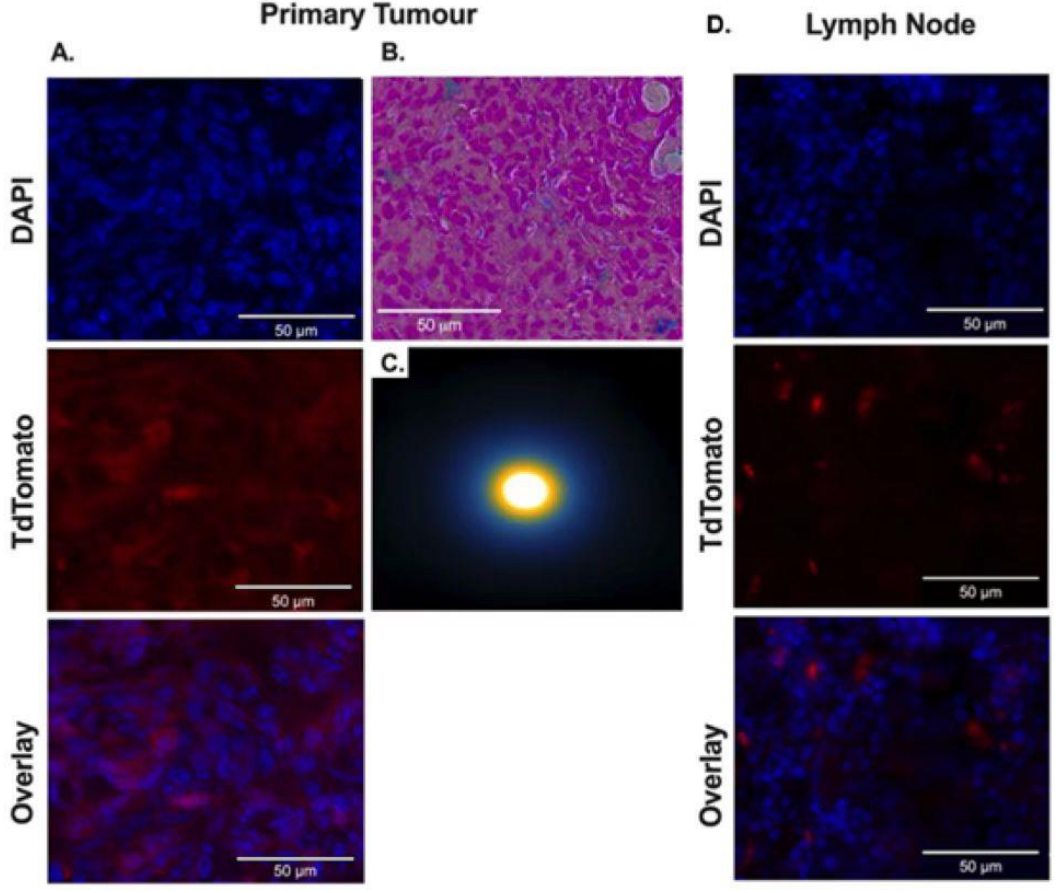
Figure 6. Ex vivo histology at endpoint. ( A ) Representative histology from the primary tumor and left axillary lymph node of mouse 3. DAPI (blue) stains all cell nuclei. Fluorescence in the tdTomato (red) channel confirms expression of the transduced reporter. All cells of the primary tumor (left column) were positive for tdTomato, and only a small fraction of cells in the lymph node were positive for tdTomato (right column). ( B ) PPB stain is displayed for one section of the primary tumor. Iron (blue) can be seen among the cancer cells, further confirming the presence of Synomag-D within the primary tumor. ( C ) Two-dimensional MPI of excised primary tumor highlights that Synomag-D was present in the tumor (MPI signal = 4.76 × 10 5